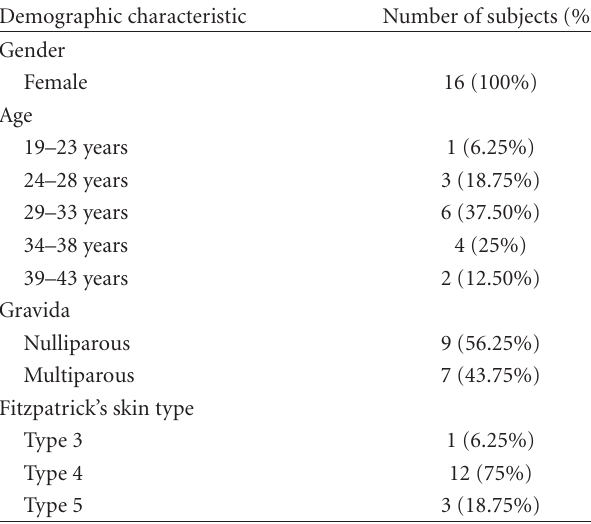
Table 1: Demographic data of the subjects. Demographic characteristic